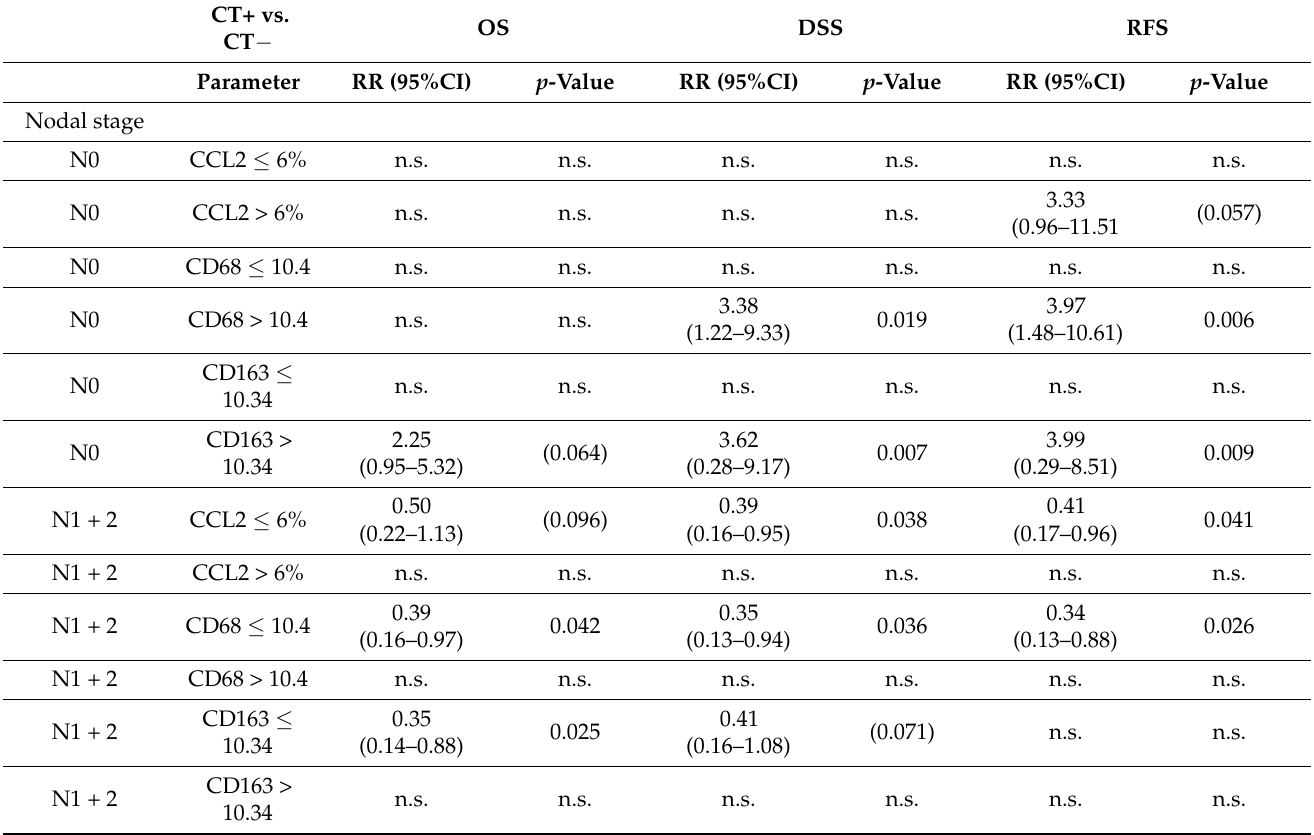
Table 2. Univariate Cox’s regression analysis: Association between chemotherapy, considering the immune markers CCL2, CD68, and CD163, and prognosis stratified by the nodal stage. CT+